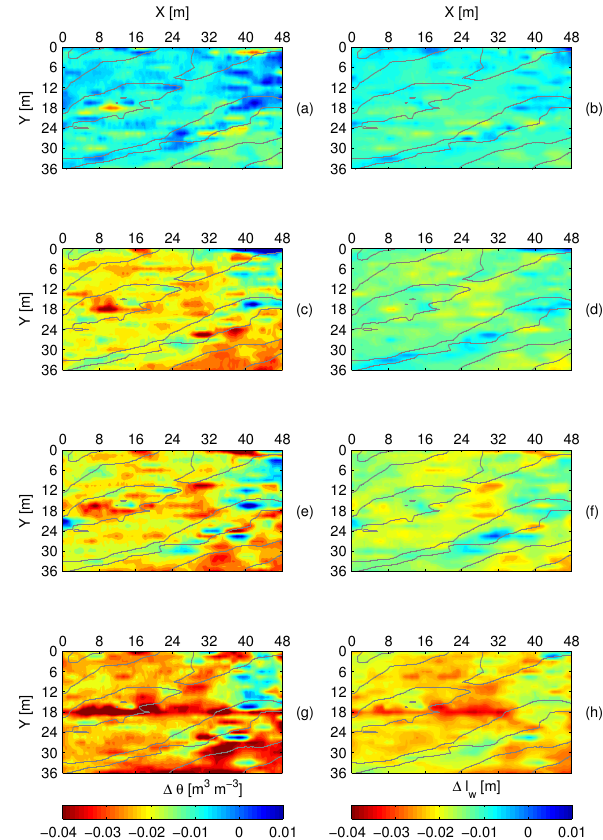
Fig. 9. Time-lapse images of measured soil water content change 1θ and total water volume change 1l w between surface and the reflector at times 23, 25, 27, and 29 May 2011 (from top to bot- tom panels) relative to the values on 22 May. The contour lines are identical to those in Fig.